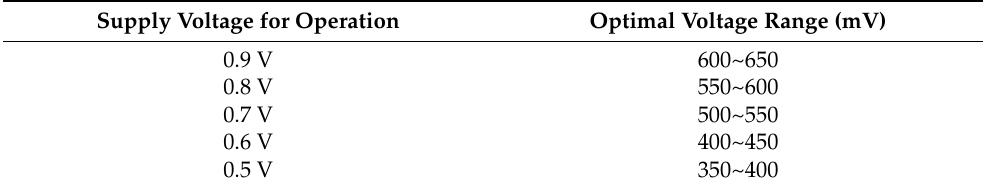
Table 1. Optimal pre- charge voltages.